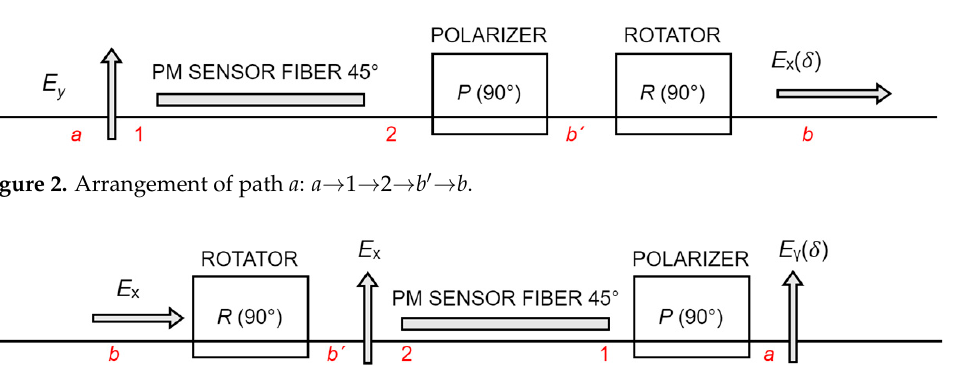
Figure 3. Arrangement of path b : b → b (cid:48) → 2 → 1 → a